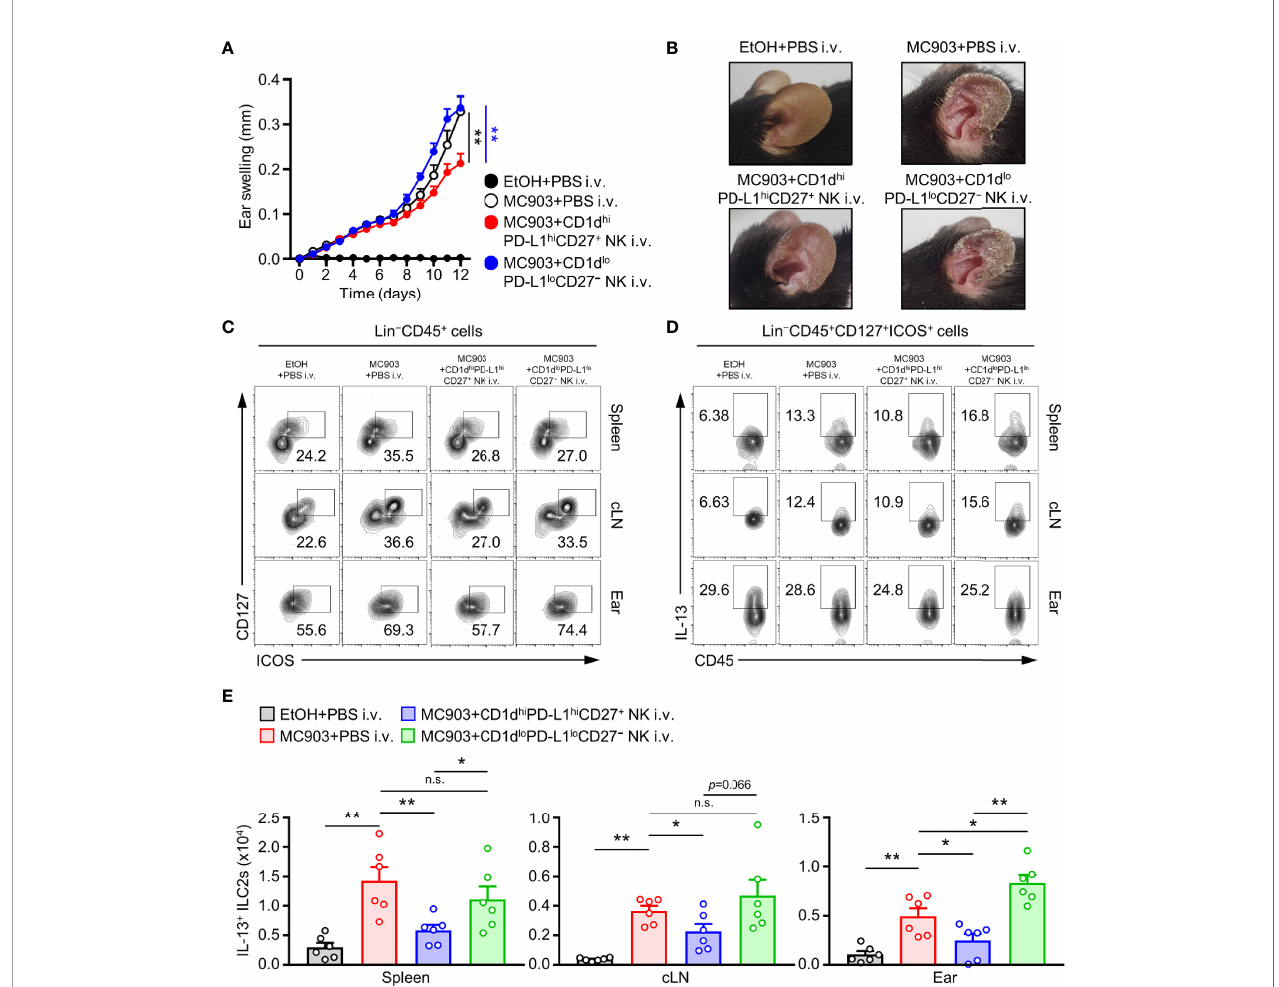
FIGURE 5 | Adoptive transferred NKreg subsets inhibits IL-13 + ILC2s activity and atopic dermatitis responses. (A) Ear thicknesses and (B) Representative ear images in MC903-induced AD mice with or without the transfer of CD1d hi PD-L1 hi CD27 + or CD1d lo PD-L1 lo CD27 – NK subset. (C) Representative fl ow cytometry images for the frequency of Lin – CD45 + CD127 + ICOS + (ILC2s), (D) IL-13 + ILC2s, and (E) histograms for the number of IL-13 + ILC2s in spleen, cLN, and ear from AD mice with or without transfer of CD1d hi PD-L1 hi CD27 + or CD1d lo PD-L1 lo CD27 – NK subset (n = 6). Data are expressed as mean ± SEM. * p < 0.05; ** p < 0.01; n.s., not signi fi